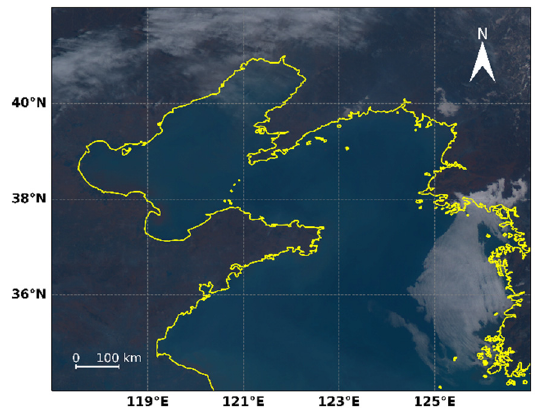
Figure 1. Himawari-8 true color image (composited by AHI observation bands B01, B02, and B03) captured on 18 March 2020, at 01:00 UTC. This area includes the Bohai Sea and the northern part of the Yellow Sea, with latitude and longitude ranging from 34°N to 42°N, 117°E to 127°E, respectively. The solid yellow lines represent coastlines.